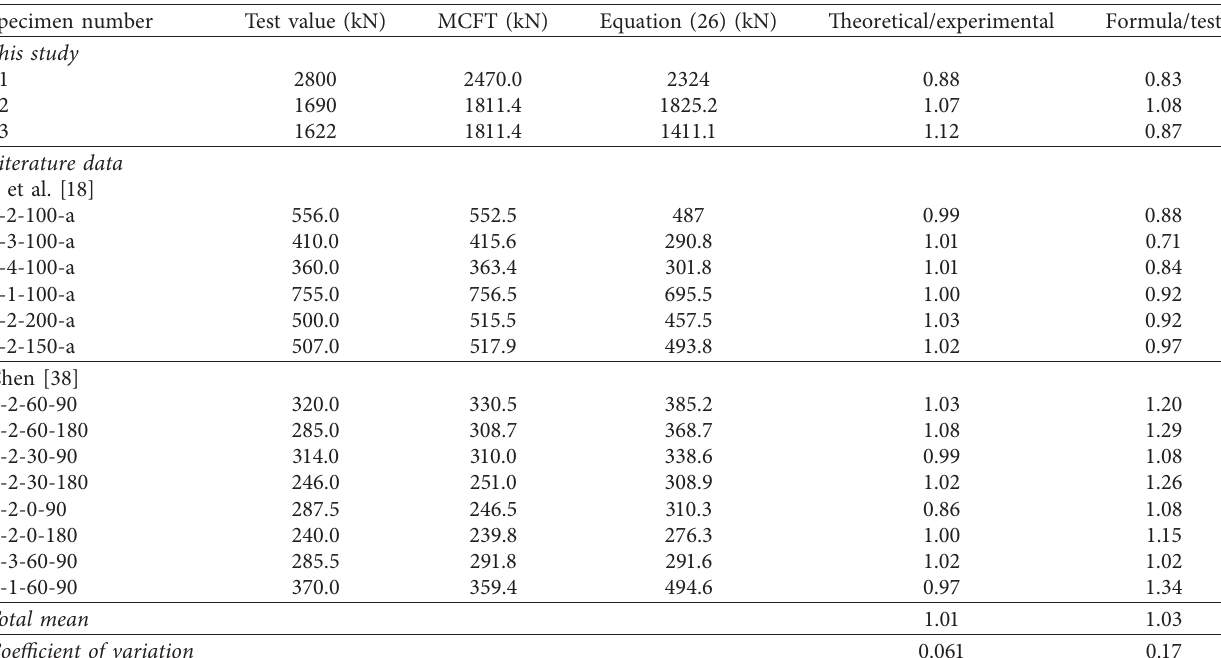
Table 6: Comparison of experimental results and predicted